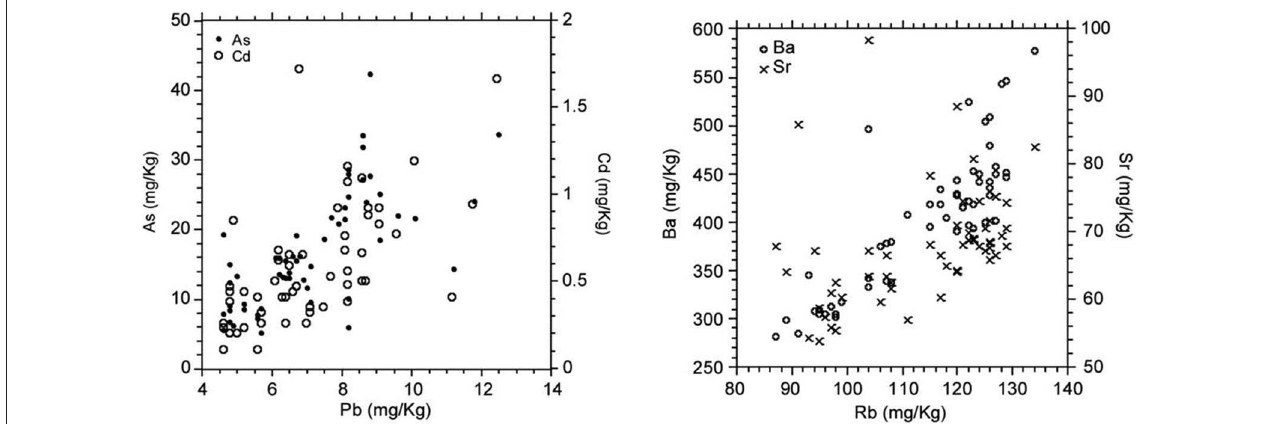
FIGURE 11 | Left : correlations among toxic elements of Pb, Cd, and As. Right : relationships among Sr, Ba, and Rb.